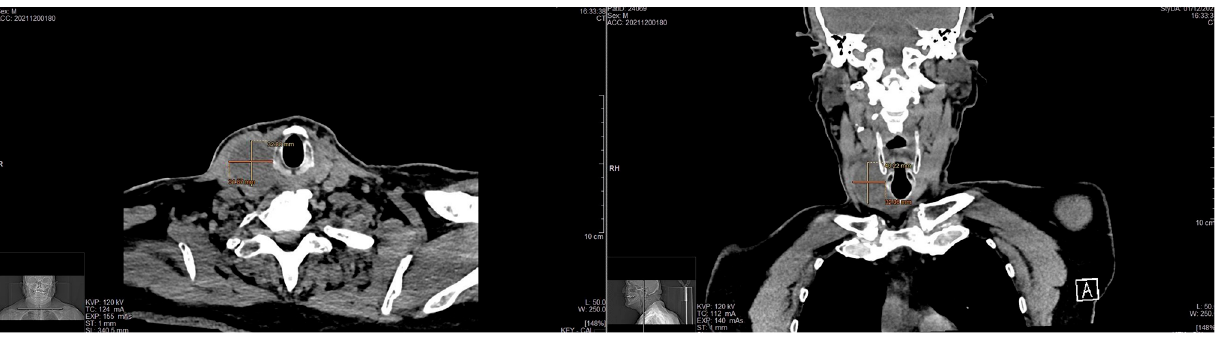
Figure 2. Axial and coronal CT scan images of the neck which confirmed the hyperplasia of the right lobe of the thyroid gland, almost completely occupied by a colliquate nodular formation.